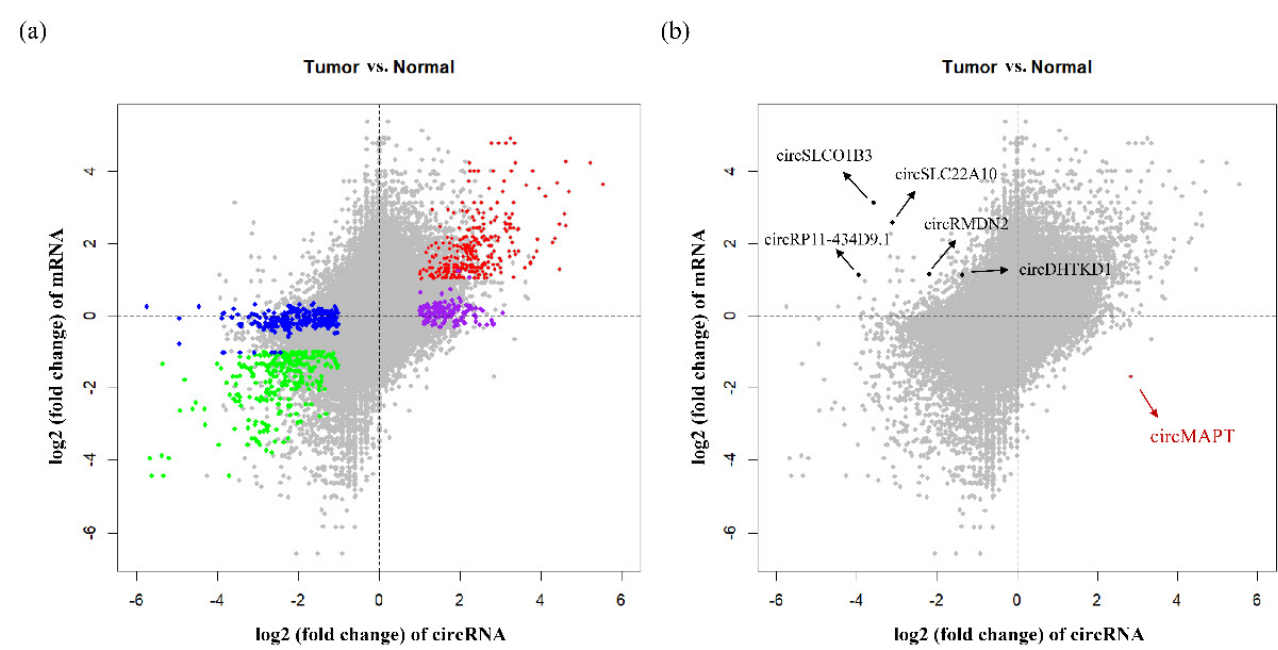
Figure 4. The correlation between log2 (fold change) of circRNAs and log2 (fold change) of linear mRNAs in HCC. ( a ) Red and green data points denote the differential expression of the circRNAs that were positively correlated with the differential expression of the linear mRNAs. Blue and purple data points denote the circRNAs that were differentially expressed in tumor samples with no corresponding change in parental gene expression. ( b ) Bold black and brown data points denote the circRNAs whose differential expression had negative correlation with the differential expression of the linear